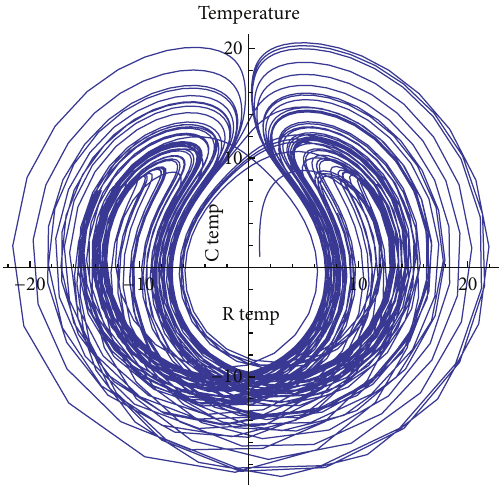
resembles a typical chaotic attractor motif, after the men- tioned initial transient, the trajectories are overlapped for longer